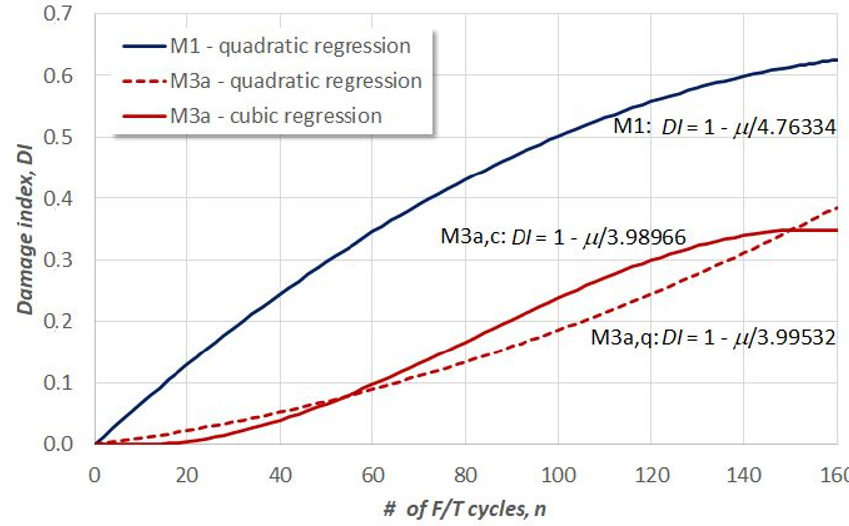
Figure 4. Damage index [DI] (Mean) as a function of the number of F/T cycles. Corresponding expressions for all three regressions are also presented. “c” and “q” denote cubic and quadratic regression, respectively.